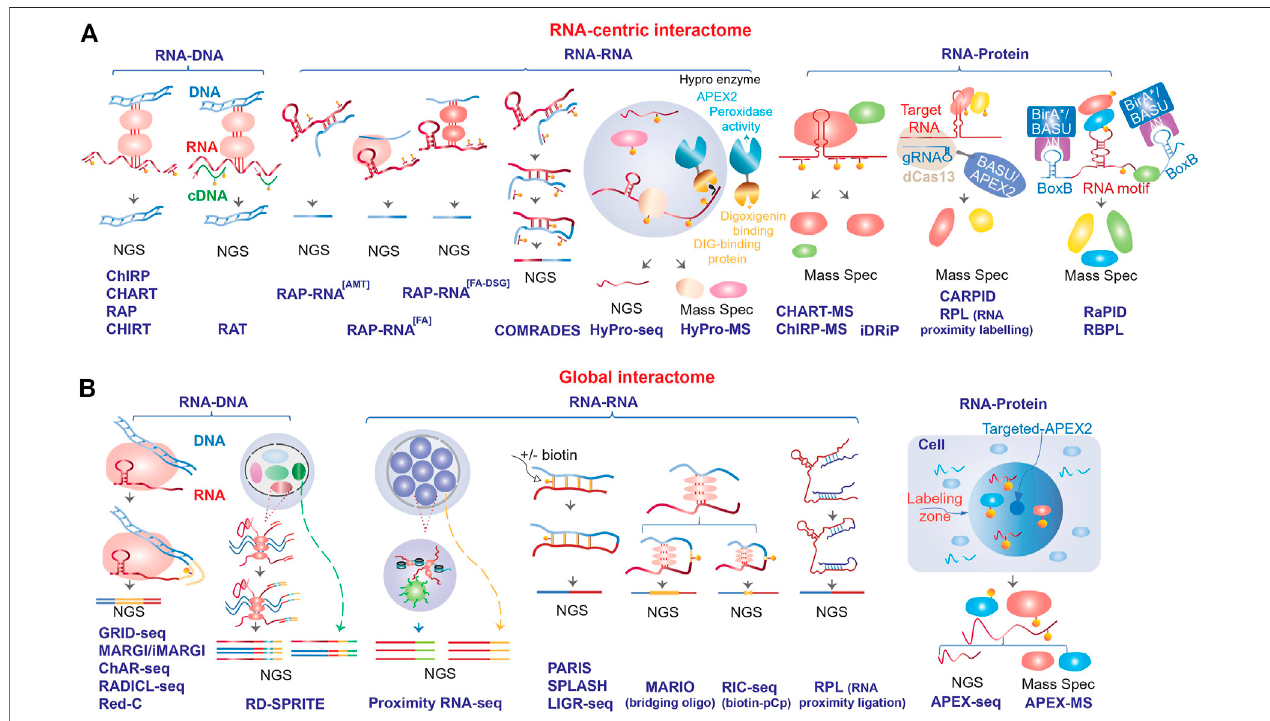
FIGURE 1 | Schematic outline of the different methods used to map RNA interactome. The methods are divided into (A) RNA-centric and (B) global, and further strati fi ed based on the type of interactions (RNA-DNA, RNA-RNA or RNA-protein) that they are designed to map (see Table 1 for more details). NGS, next generation